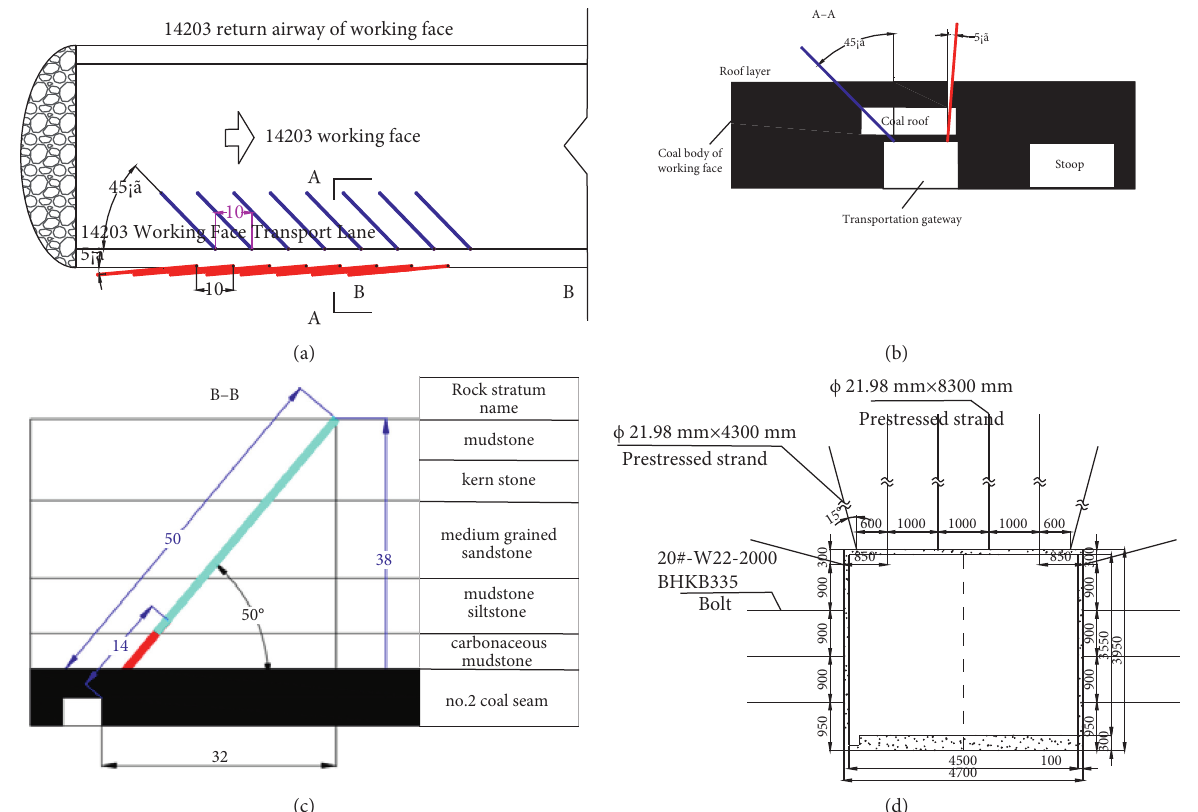
Figure 10: Hydraulic fracturing and supporting parameters of rubber haulage gateway 14203. (a) Drilling layout plan. (b) Section A-A. (c) Section B-B. (d) Sectional view of rubber-tire haulage gateway